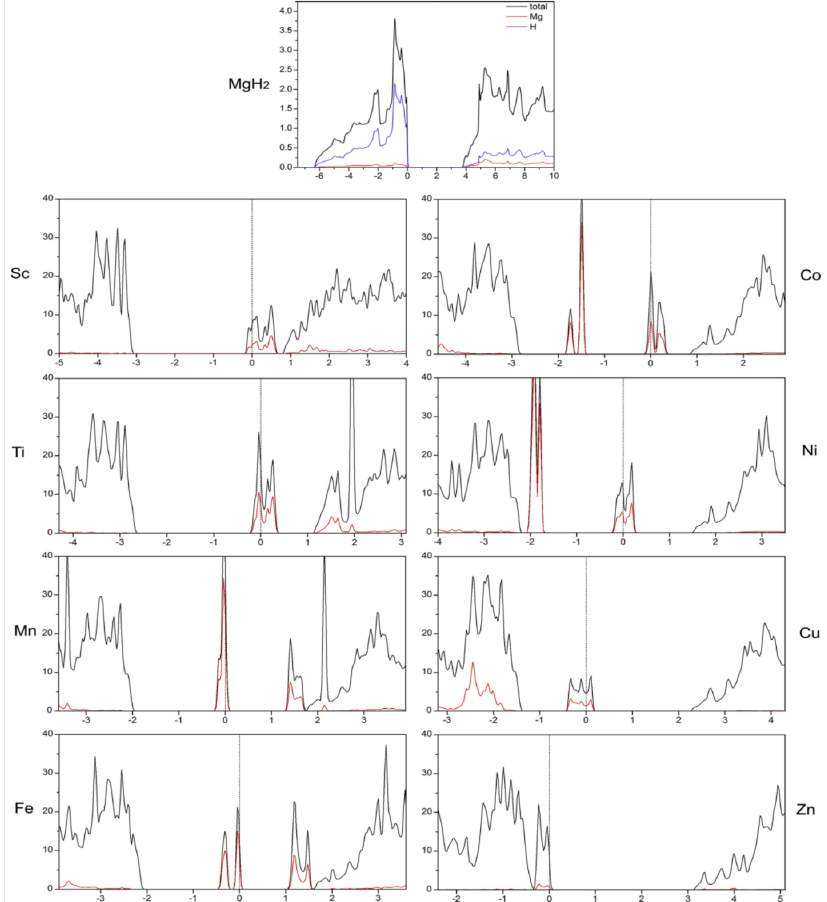
Figure 14. ( Top ) total and atomic DOS of MgH 2 ; ( bottom ) total (black) and TM projected (red) DOS of some of the MgH 2 :TM series members (Mg 15 TMH 32 ). Fermi level is denoted with the dashed vertical line. Only the top of valence and bottom of conduction bands are shown. Reproduced with permission [28]. Copyright 2014,